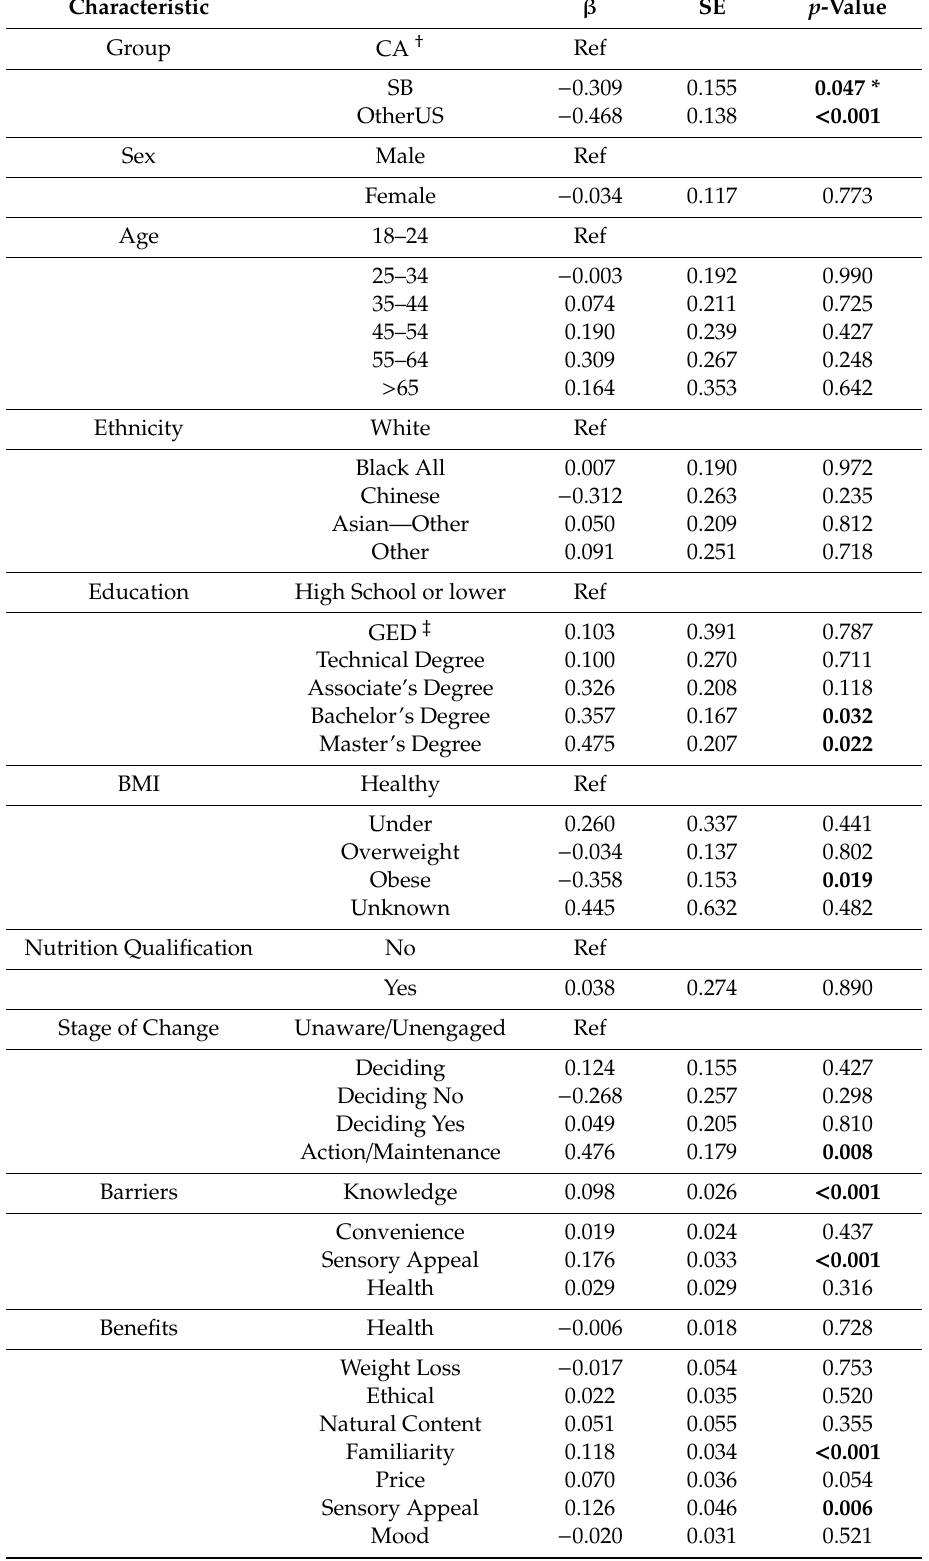
Table 2. Multivariable linear regression analysis assessing Mediterranean diet adherence between groups adjusted for demographic categories, stages of change, barriers, and